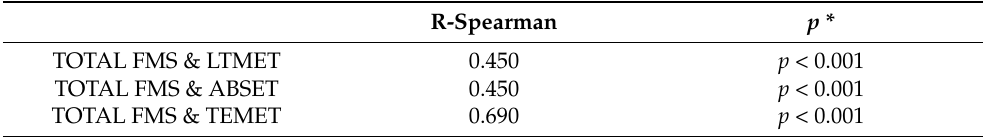
Table 7. Correlations between the FMS composite score and core stability test